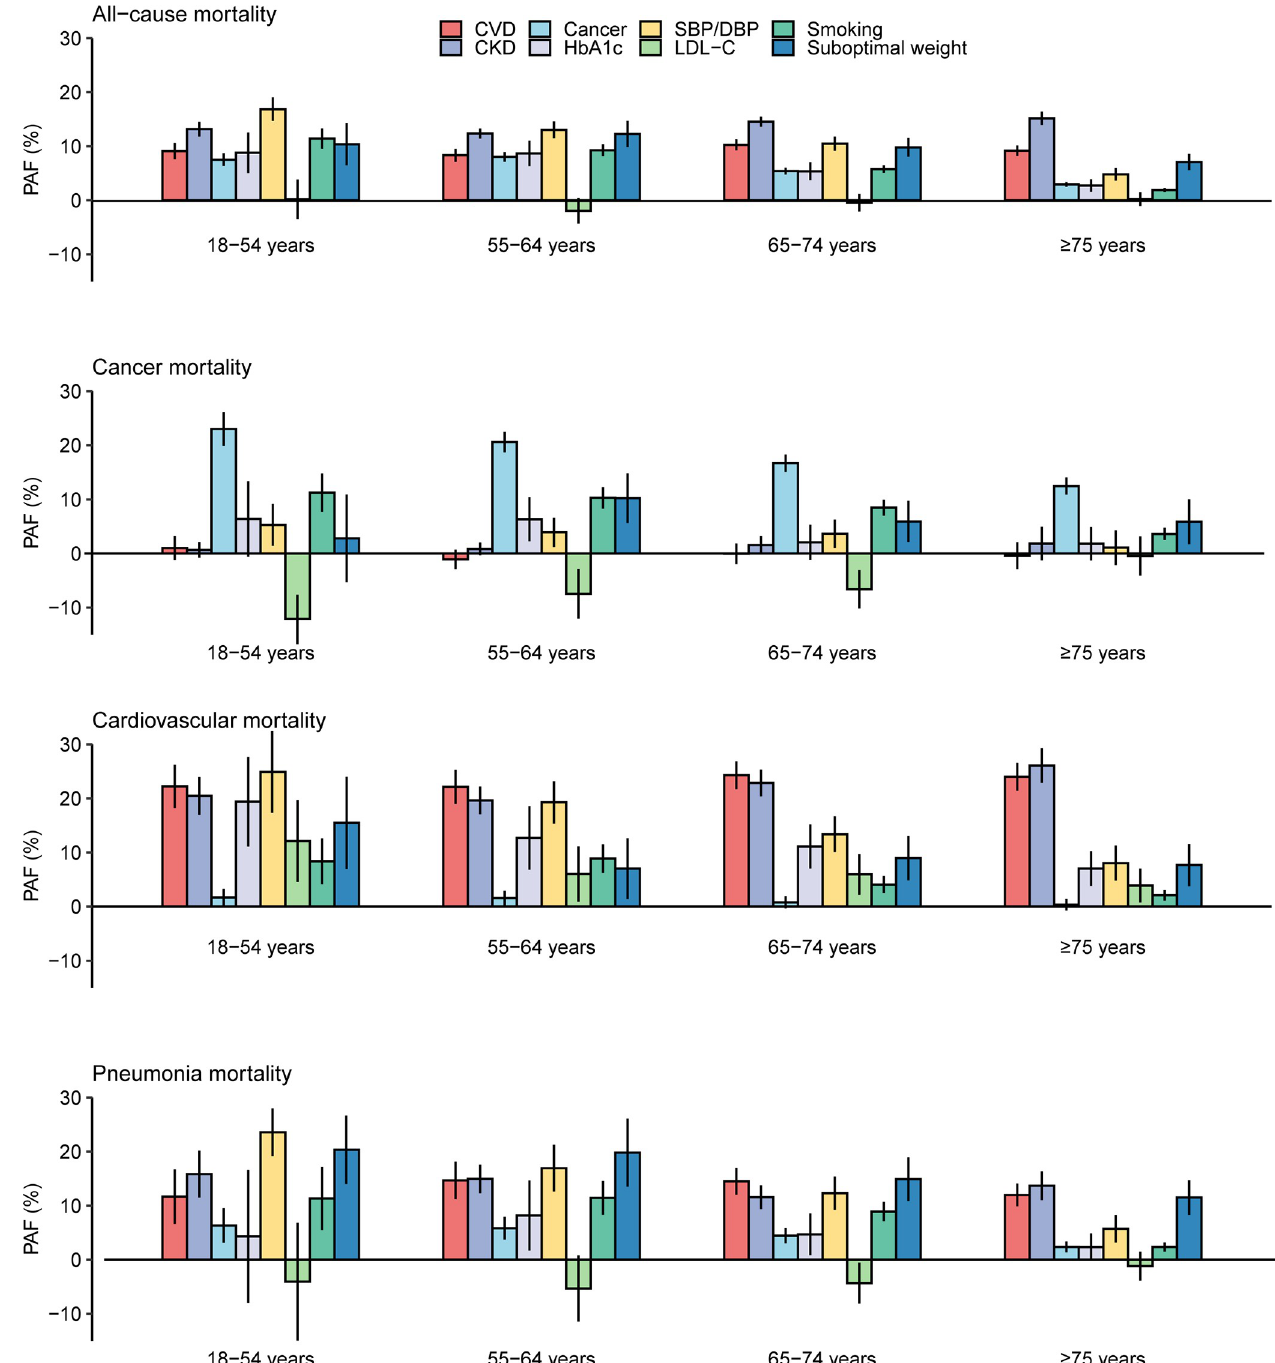
Fig 2. PAFs of risk factors for all-cause and selected cause-specific mortality by age in people with type 2 diabetes. The whiskers indicate the 95% CI. CI, confidence interval; CKD, chronic kidney disease; CVD, cardiovascular disease; DBP, diastolic blood pressure; HbA1c, haemoglobin A1c; LDL-C, low-density lipoprotein cholesterol; PAF, population attributable fraction; SBP, systolic blood pressure.